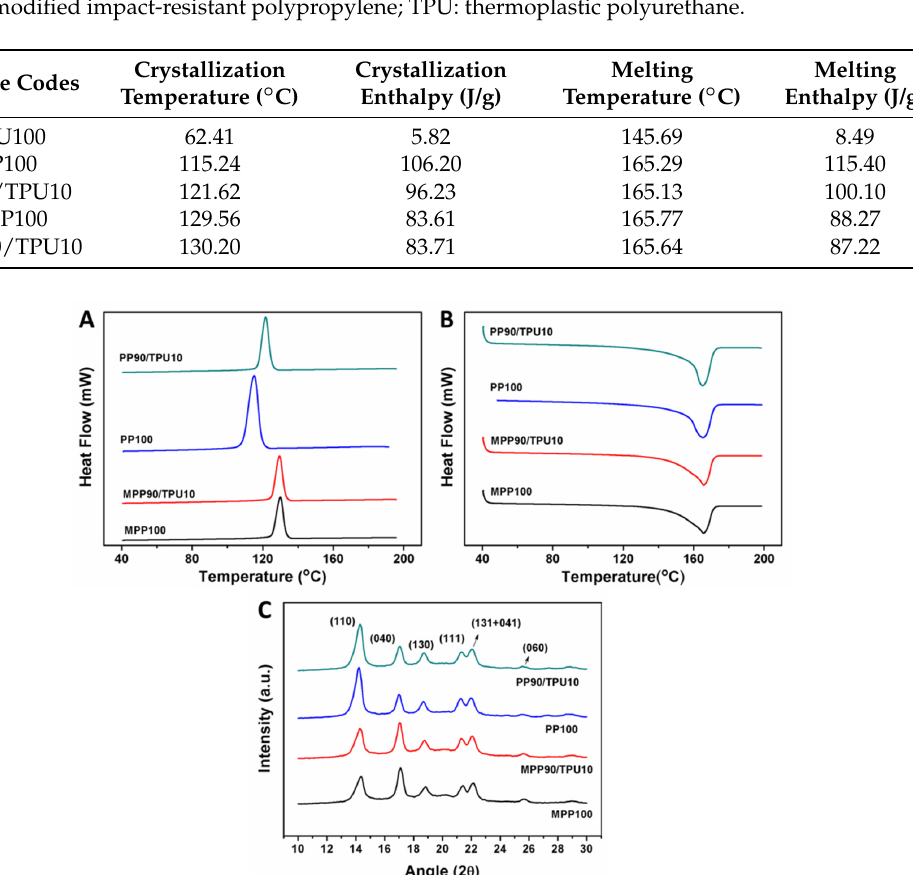
Table 1. Melting and crystalline behavior of PP/TPU blends and MPP/TPU blends. PP: polypropylene;